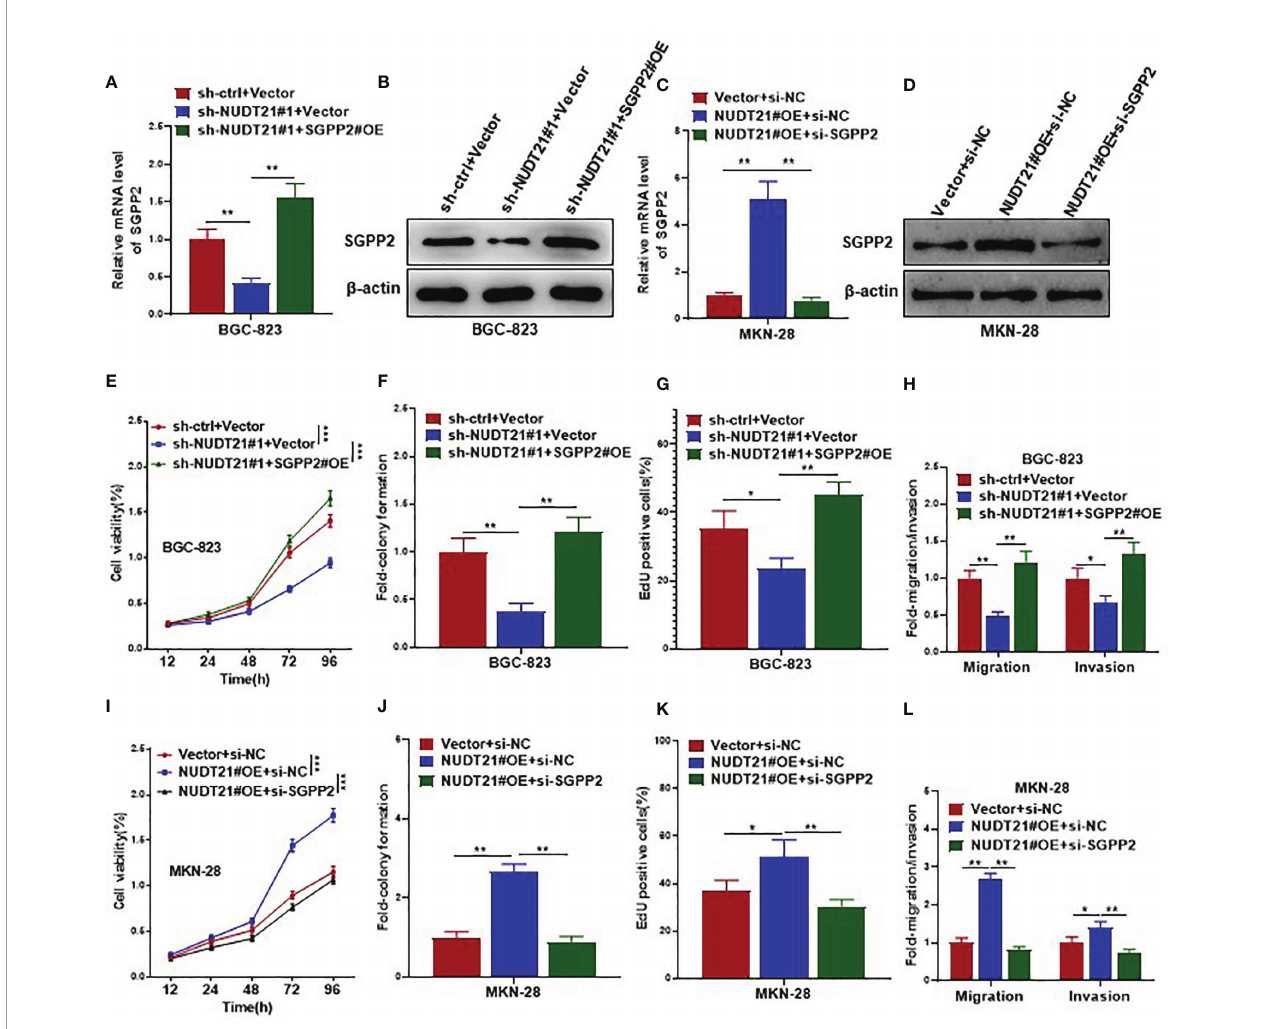
FIGURE 5 | SGPP2 mediated the oncogenic role of NUDT21 in gastric cancer cells. BGC-823 cells were co-transfected with sh-NUDT21#1/sh-ctrl and SGPP2#OE/Vector, MKN-28 cells were co-transfected with NUDT21#OE/Vector and si-SGPP2/si-NC. (A, C) mRNA levels of SGPP2 were examined by RT-qPCR. GAPDH was used as control. (B, D) Protein levels of SGPP2 were examined by western blot. b -Actin was used as control. (E, I) MTT assay was carried out to detect cell viability. (F, J) Cell colony formation assay was performed to evaluate cell growth. (G, K) EdU assay was performed to evaluate cell proliferation. (H, L) Cell migration and invasion assays were carried out to detect cell metastasis. * P < 0.05; ** P < 0.01; *** P <